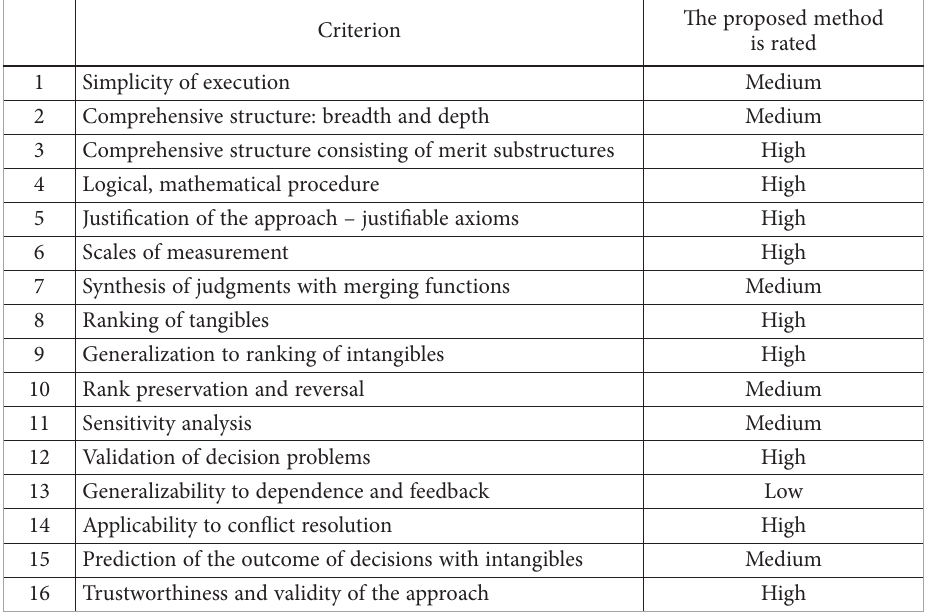
Table 9. Summarizes the performance of the proposed method regard to the above criteria